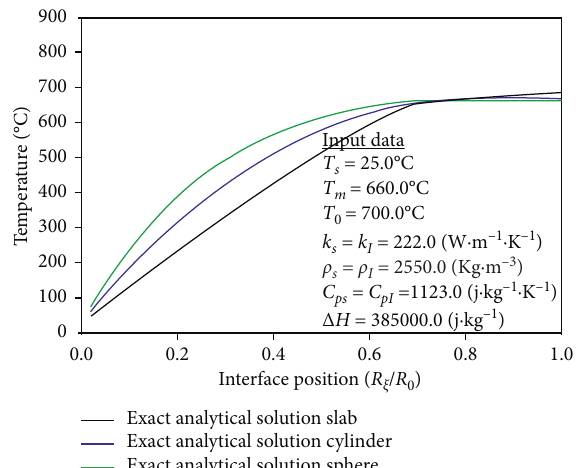
Figure 21: Comparison of concentration profiles during inward two-phase solidification of a slab, a cylinder, and a sphere as a function of dimensionless position ( R